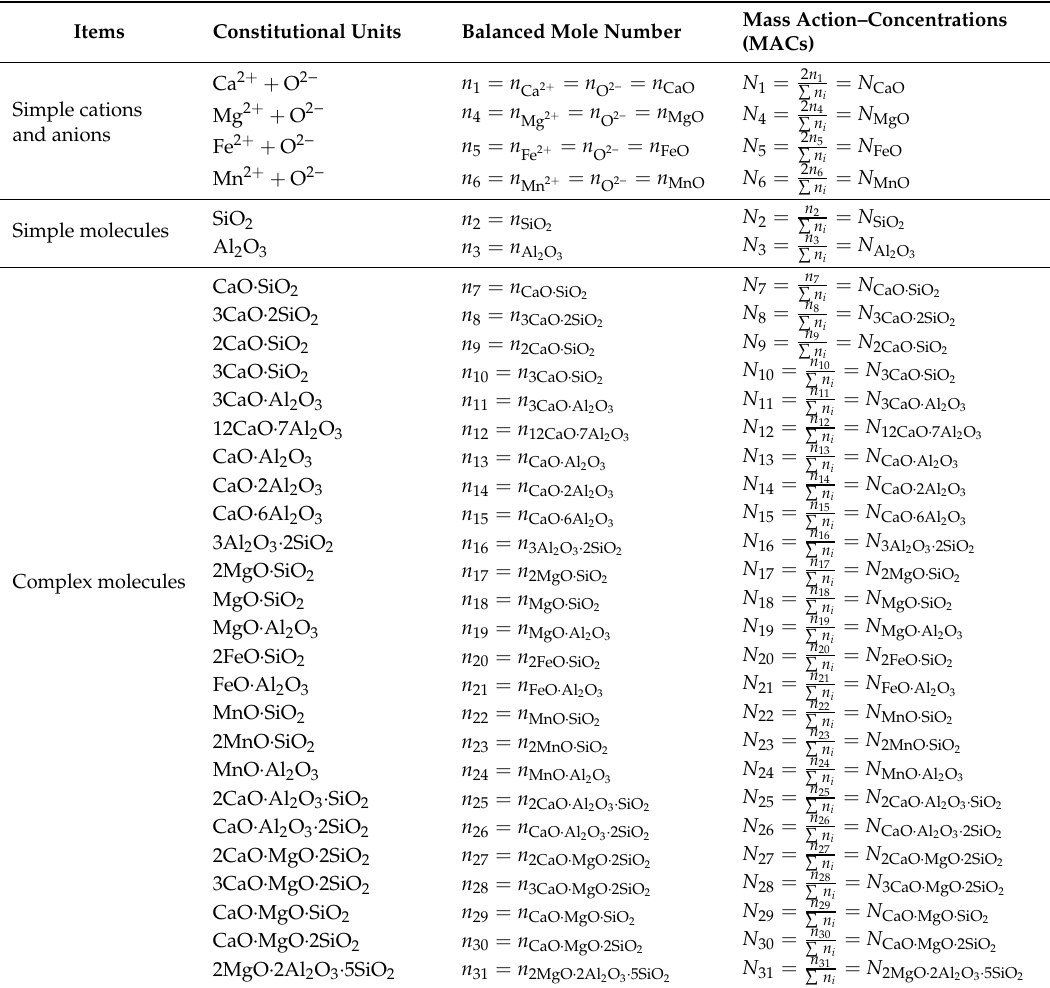
Table 4. Parameters of the structural units in the slag